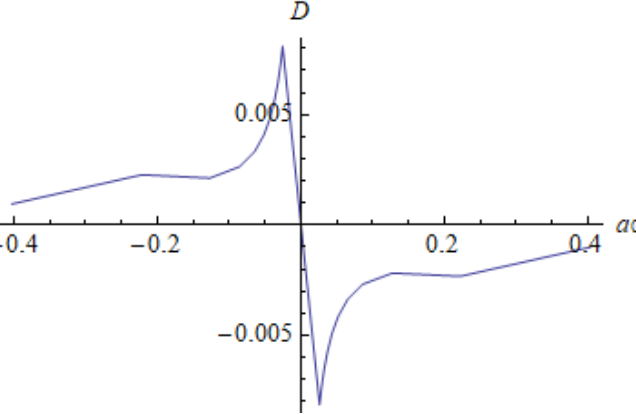
Figure 4. Variation of trJ with respect to amplitude a 0 , given by Equation (77) .